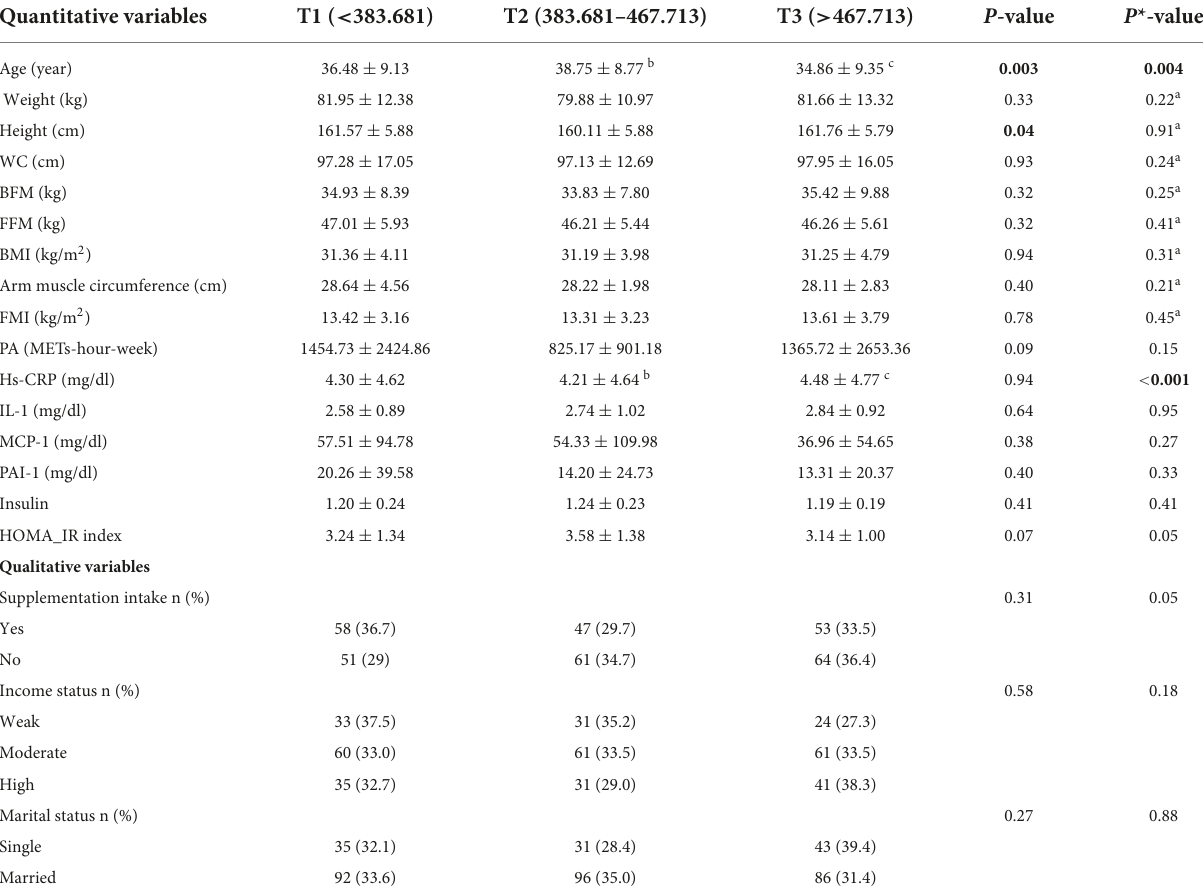
TABLE 1 Distribution of general variables of the participants among tertiles of UPF